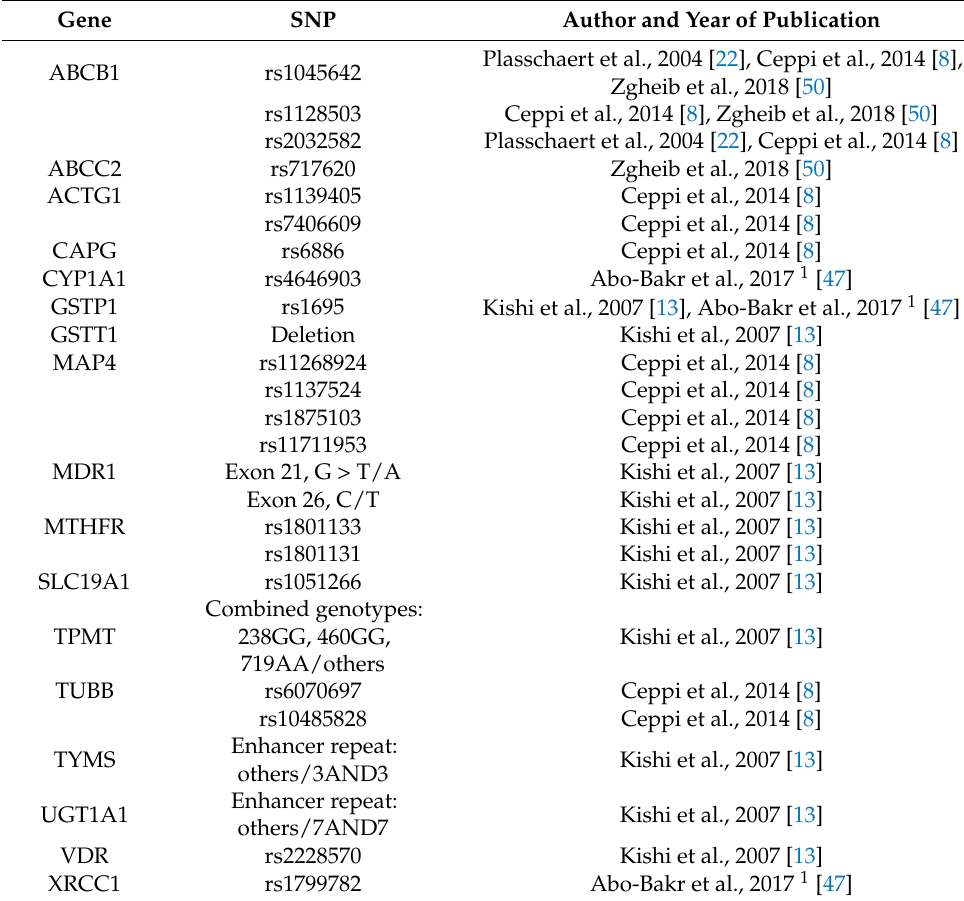
Table 3. Single-nucleotide polymorphisms that were not significantly associated with vincristine- induced peripheral neuropathy in the pediatric oncology